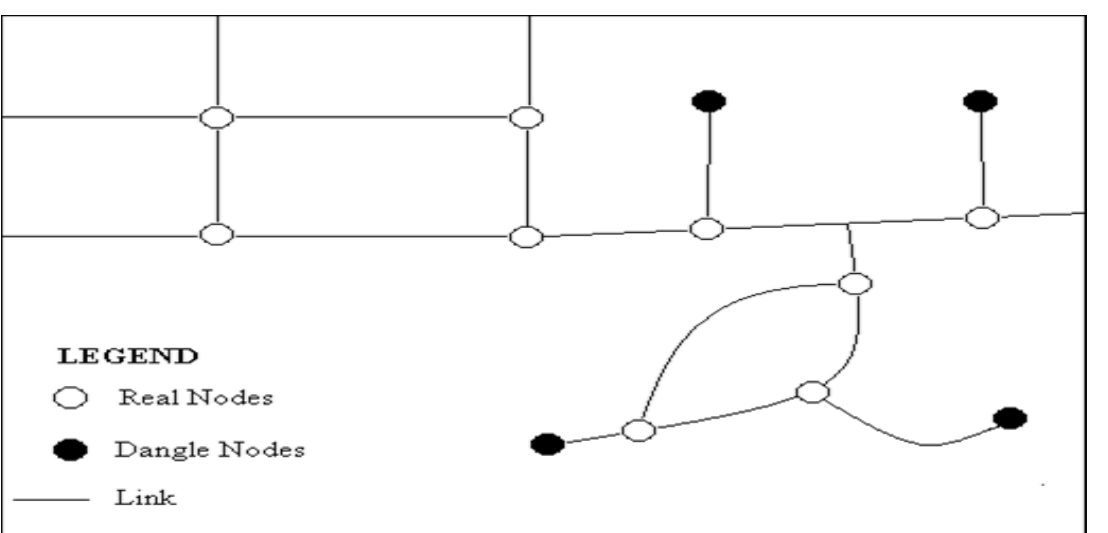
Figure 1. Components of the street connectivity